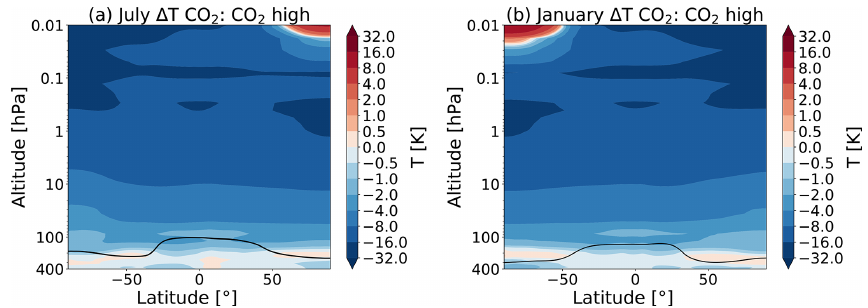
Figure 2. Partial temperature change due to the direct forcing of CO 2 for July (a) and January (b) due to the doubling of the atmospheric CO 2 concentration, as calculated by the climate feedback response analysis method (CFRAM) using experiments S1 and C1. The black line indicates the tropopause height for the S1 run (with a double CO 2